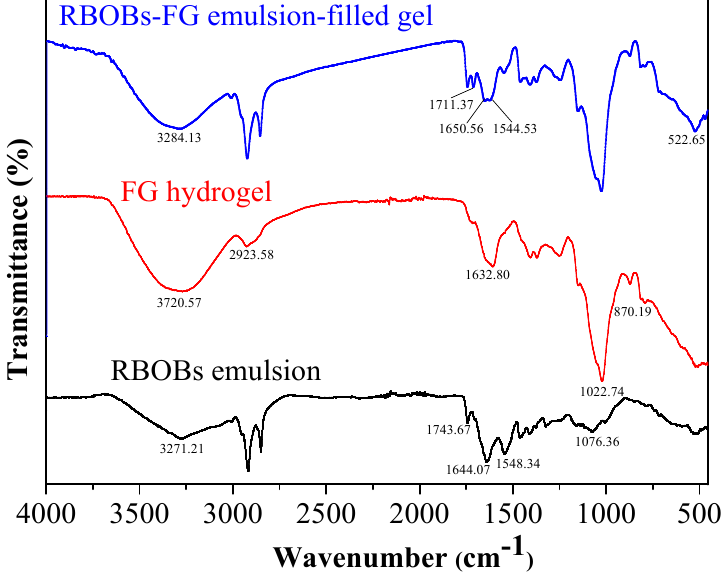
Figure 2. FT-IR spectra of RBOB-FG emulsion-filled gel, FG hydrogel, and RBOB emulsion.